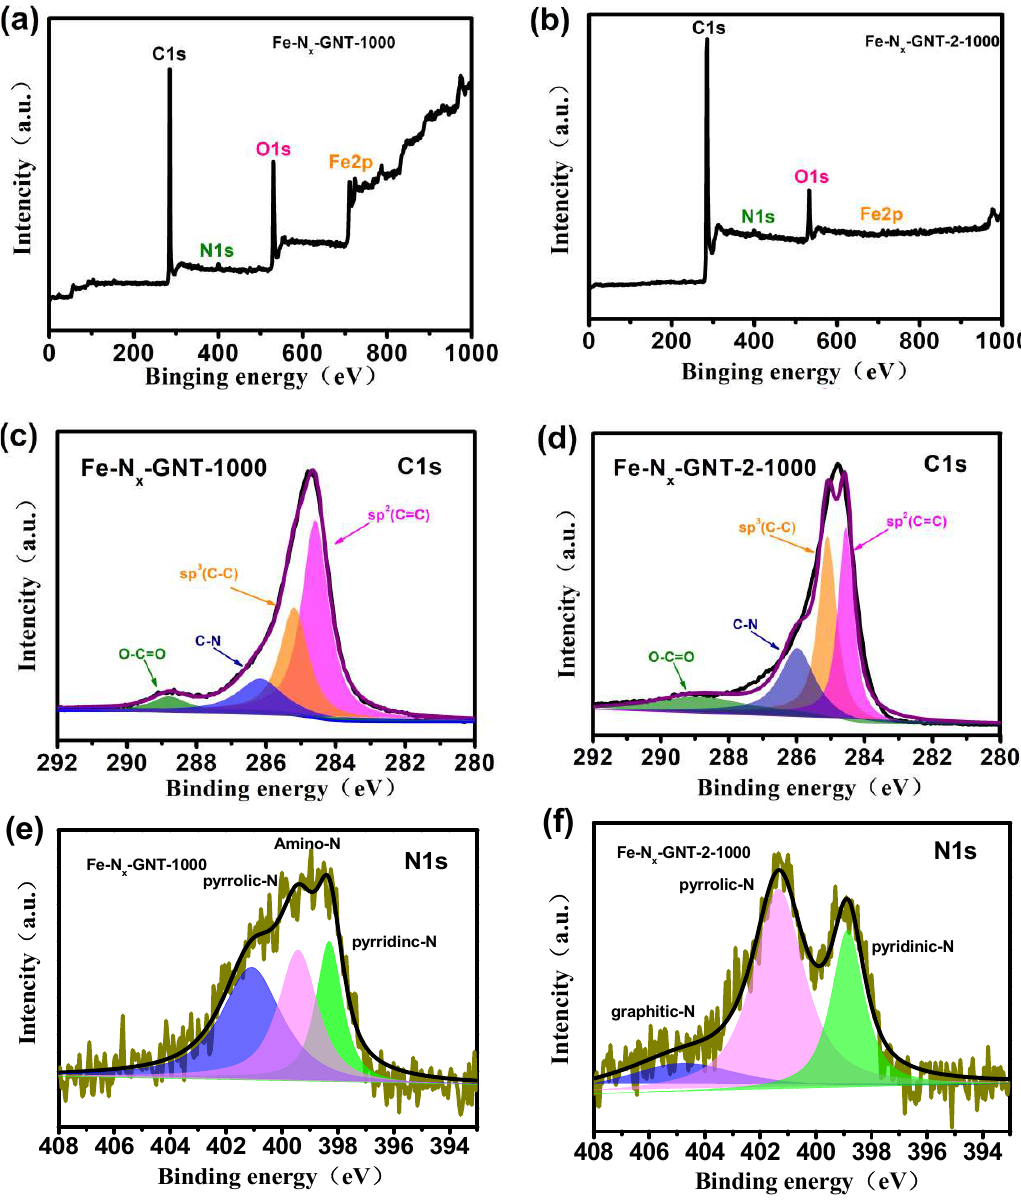
Figure 4. ( a ) Survey scan XPS spectrum of Fe-N x -GNT-1000. ( b ) Survey scan XPS spectrum of Fe-N x -GNT-2-1000. ( c ) C1s spectrum of Fe-N x -GNT-2-1000. ( d ) C1s spectrum of Fe-N x -GNT-2-1000. ( e ) N1s spectrum of Fe-N x -GNT-1000. ( f ) N1s spectrum of Fe-N x -GNT-2-1000.